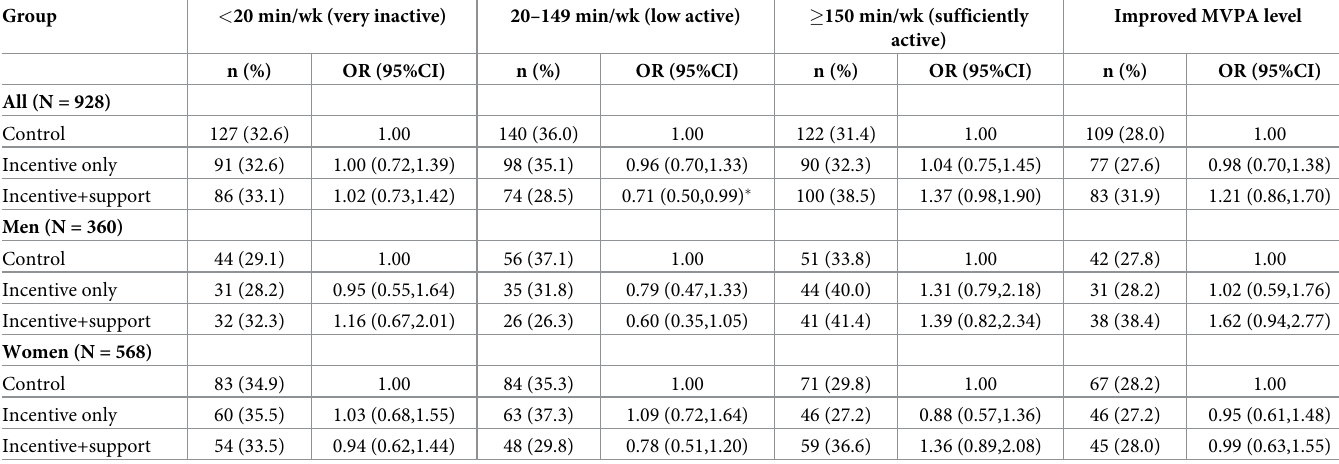
Table 4. PA level and improvement over 12